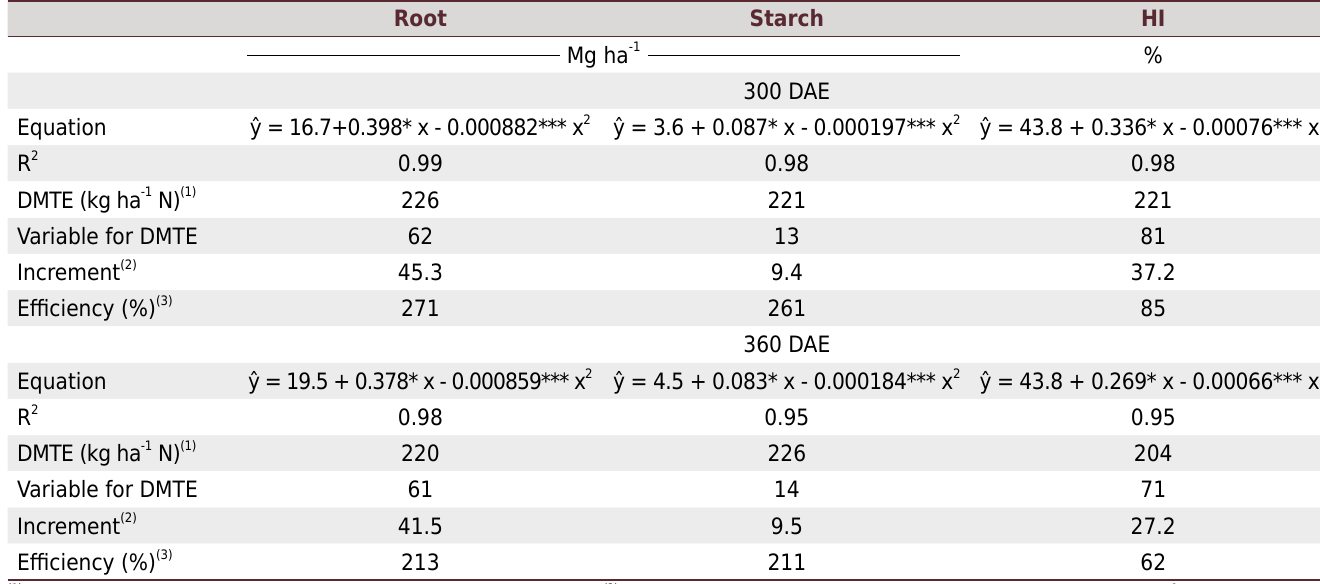
(1) DMTE: dose of maximum technical efficiency for N topdressing. (2) Increment: variable for DMTE - variable for a dose of 0 kg ha -1 of N topdressing. (3) Efficiency (%) = {[(variable for DMTE × 100)/(variable for a dose of 0 kg ha -1 of N topdressing)] - 100}. * and ***: significant at 5 and 0.1 % probability by the F-test,